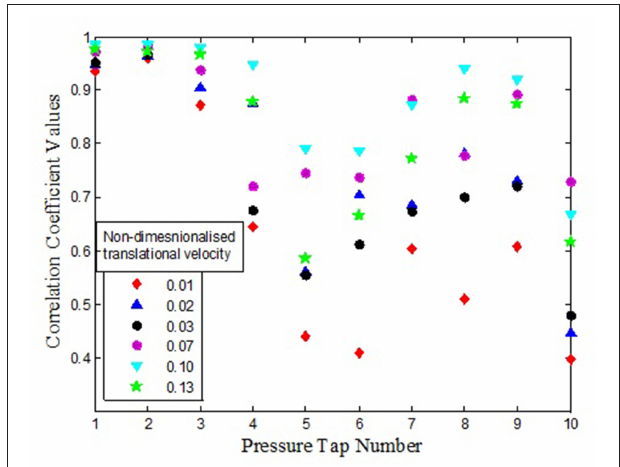
FIGURE 15 | Correlation coefficient values for opening on leeward